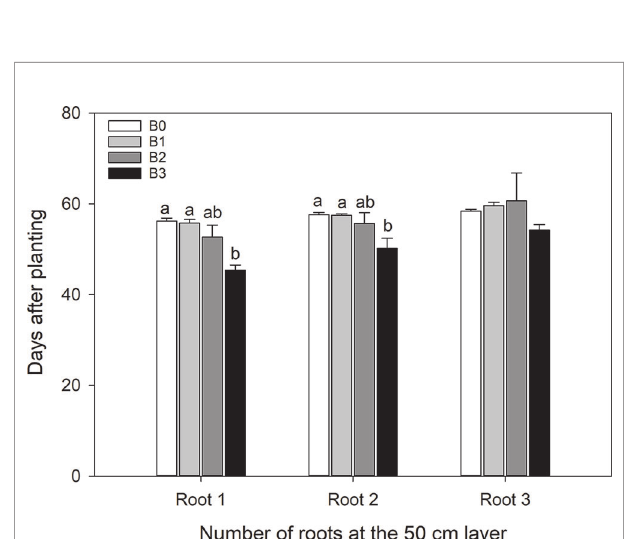
FIGURE 6 | Day of arrival of fi rst, second and third root to the 50 cm depth after passing the subsoil layer with different biochar levels. Values are averaged over irrigation treatments. Error bars indicate standard errors of the mean (n=5(B0), 3(B1), 3(B2), 5(B3)). Different letters indicate signi fi cant difference. Letters are not shown when there is no signi fi cant